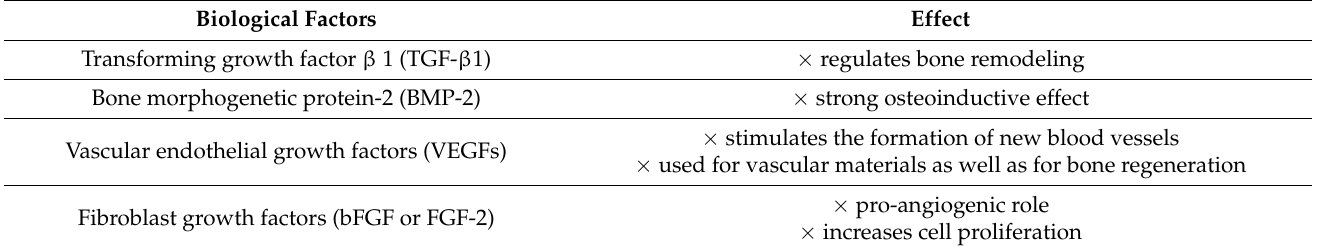
Table 2. Biological factors and their effect on biocompatibility